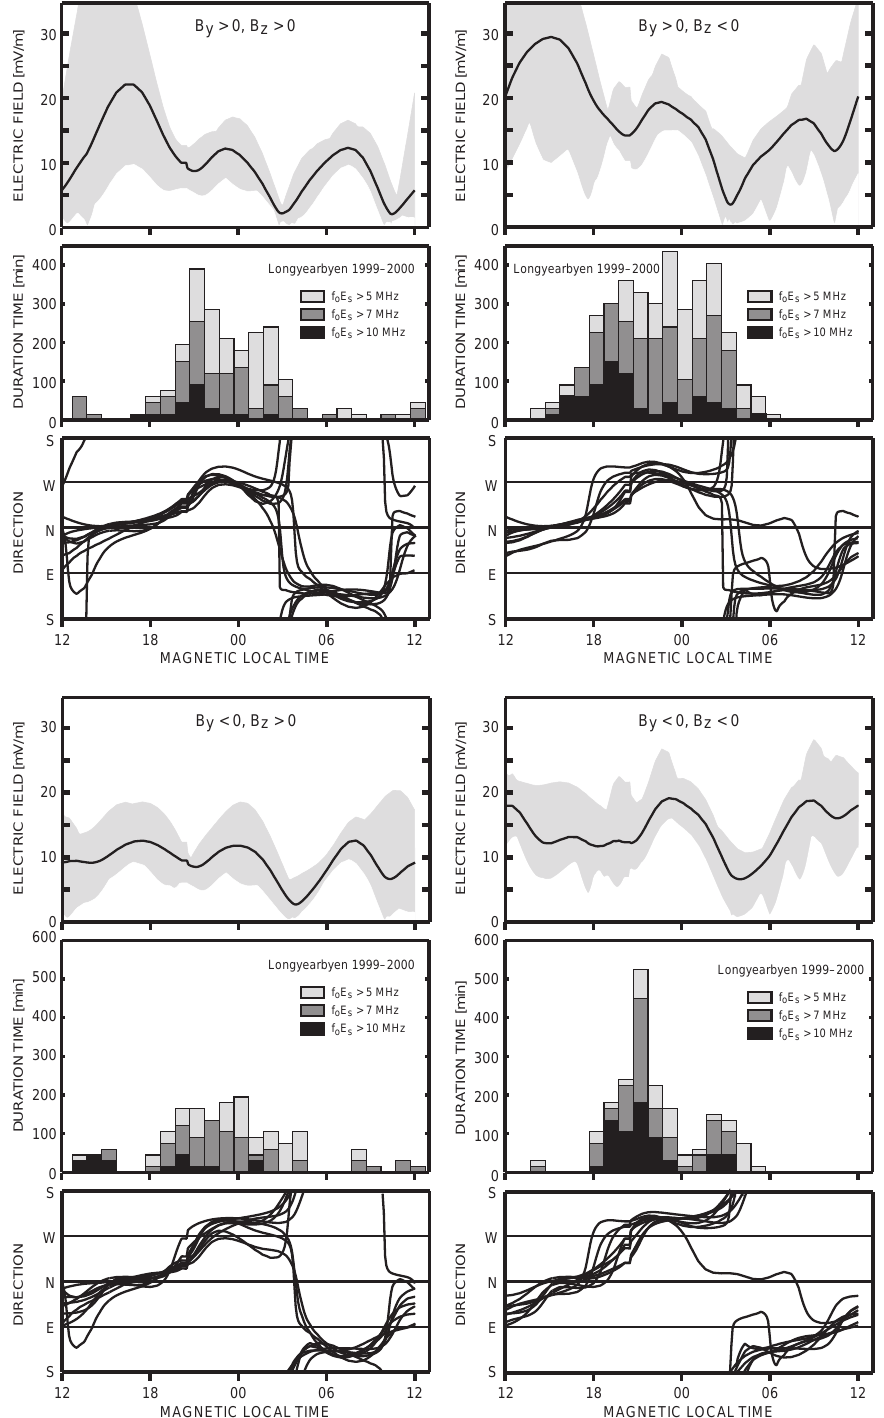
Fig. 4. Diurnal variations of electric field direction (bottom panels) and amplitude (top panels), calculated for different orientations of the IMF within each quadrant of the B y B z plane, together with daily variations of sporadic-E occurrence observed at Longyearbyen in 1999– 2000 (middle panels). The field direction is calculated from the APL convection model, using all directions of the IMF projection (the resolution of the model is 45 ◦ ) and values 4, 6 and 8nT. The electric field directions are plotted by separate curves. The mean electric field amplitude is plotted by a continuous curve and the whole range of amplitude variation by grey shading. Separate Es distributions are plotted for layers with peak plasma frequencies higher than 5, 7 and